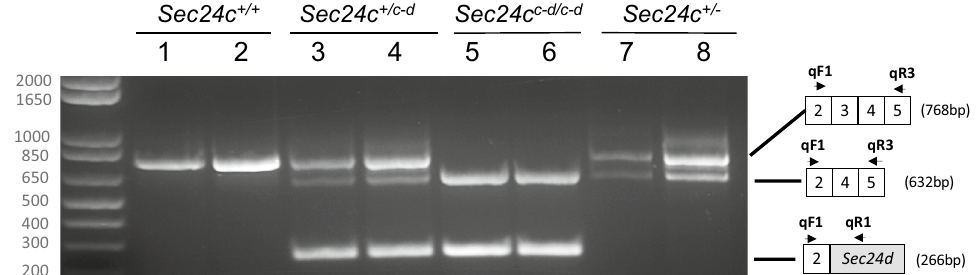
Figure 5. Analysis of Sec24c c-d allele splicing. A three-primer RT-PCR reaction using qF1, qR1 and qR3 demonstrates the presence of Sec24c c-d allele splice variants. Primers qF1 and qR3 (see schematic at the right) detected mRNA transcripts from both the wild type allele (exons 2–3-4–5) and the transcript skipping exon 3 (2-4-5) present in mice carrying the Sec24c c-d allele, resulting from splicing around the dRMCE insertion (lanes 3–6), as well as mice carrying the Sec24c - allele, in which exon 3 was also excised (lanes 7–8). Primers qF1 and qR1 detect the mRNA transcript of the Sec24d cDNA insert in Sec24c + /c-d and Sec24c c-d/c-d mice (lanes 3–6), and this transcript is absent in wild type littermates (lanes 1–2), or Sec24c + /− mice (lanes